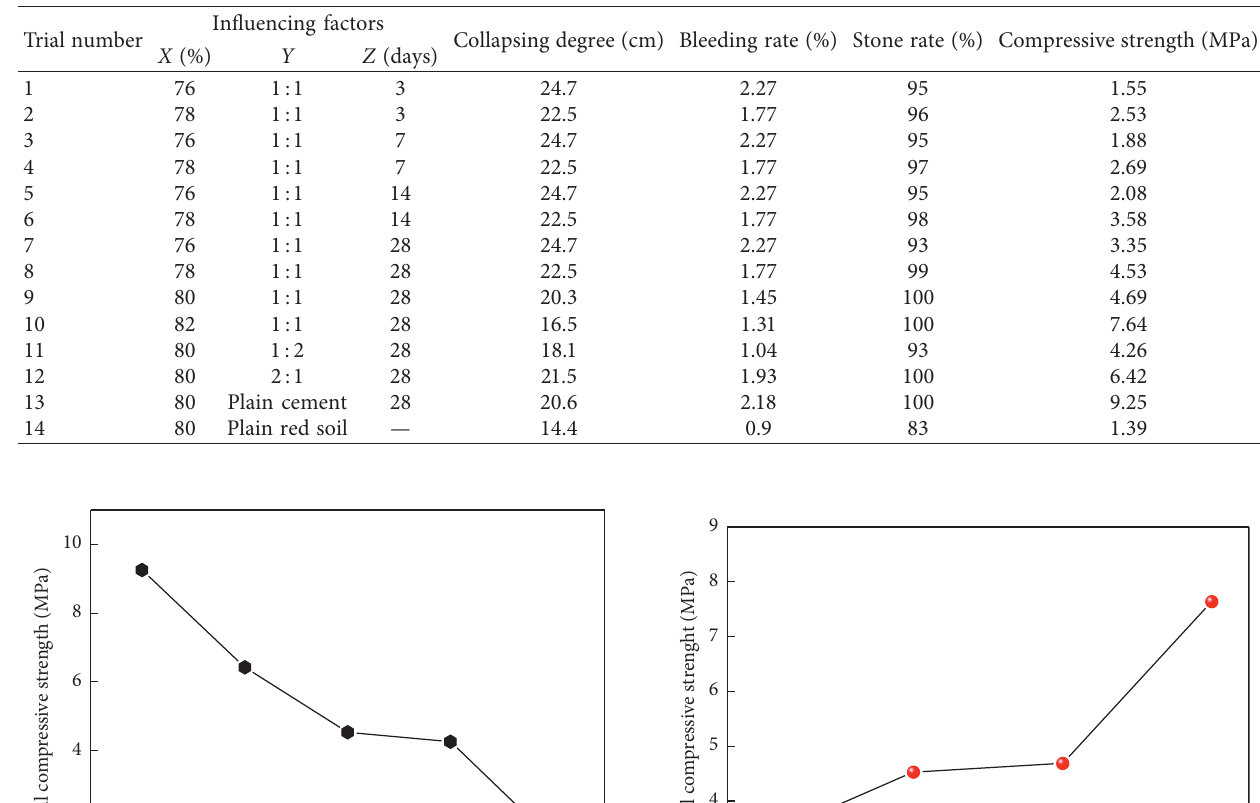
Figure 5: Part of the test after release. Table 7: Results of the paste performance test.